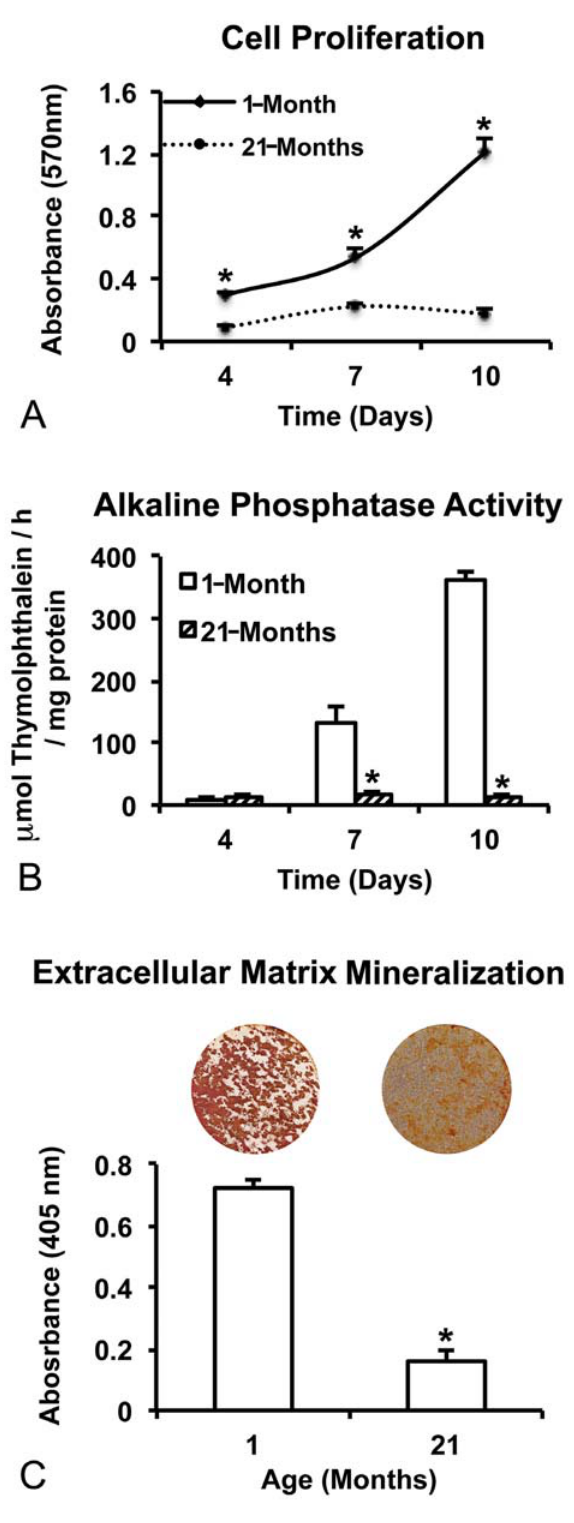
Figure 1- Proliferation (A) and alkaline phosphatase (ALP) activity at days 4, 7, and 10 (B) and extracellular matrix mineralization at day 21 (C) of cultures from 1-month and 21-month rats grown on Ti discs. Data are presented as (cid:87)(cid:75)(cid:72)(cid:3)(cid:80)(cid:72)(cid:68)(cid:81)(cid:147)(cid:86)(cid:87)(cid:68)(cid:81)(cid:71)(cid:68)(cid:85)(cid:71)(cid:3)(cid:71)(cid:72)(cid:89)(cid:76)(cid:68)(cid:87)(cid:76)(cid:82)(cid:81)(cid:3)(cid:11)(cid:81)(cid:32)(cid:24)(cid:12)(cid:17)(cid:3)(cid:13)(cid:3)(cid:76)(cid:81)(cid:71)(cid:76)(cid:70)(cid:68)(cid:87)(cid:72)(cid:86)(cid:3)(cid:86)(cid:76)(cid:74)(cid:81)(cid:76)(cid:191)(cid:70)(cid:68)(cid:81)(cid:87)(cid:3) differences between cells from 1-month and 21-month